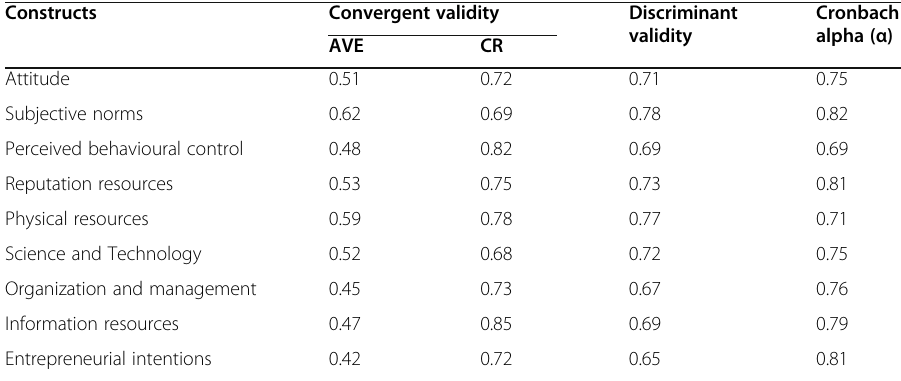
Table 2 Validities